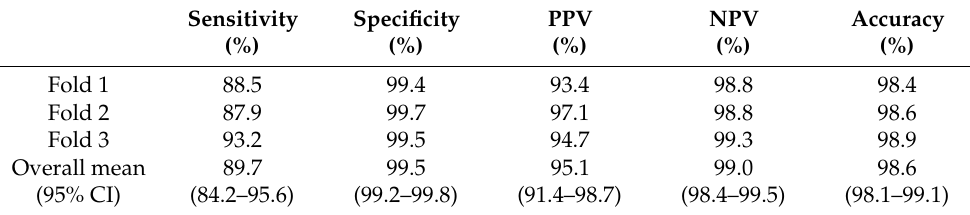
Table 1. Three-fold cross-validation, which was performed during the training phase. Sensitivity (%)